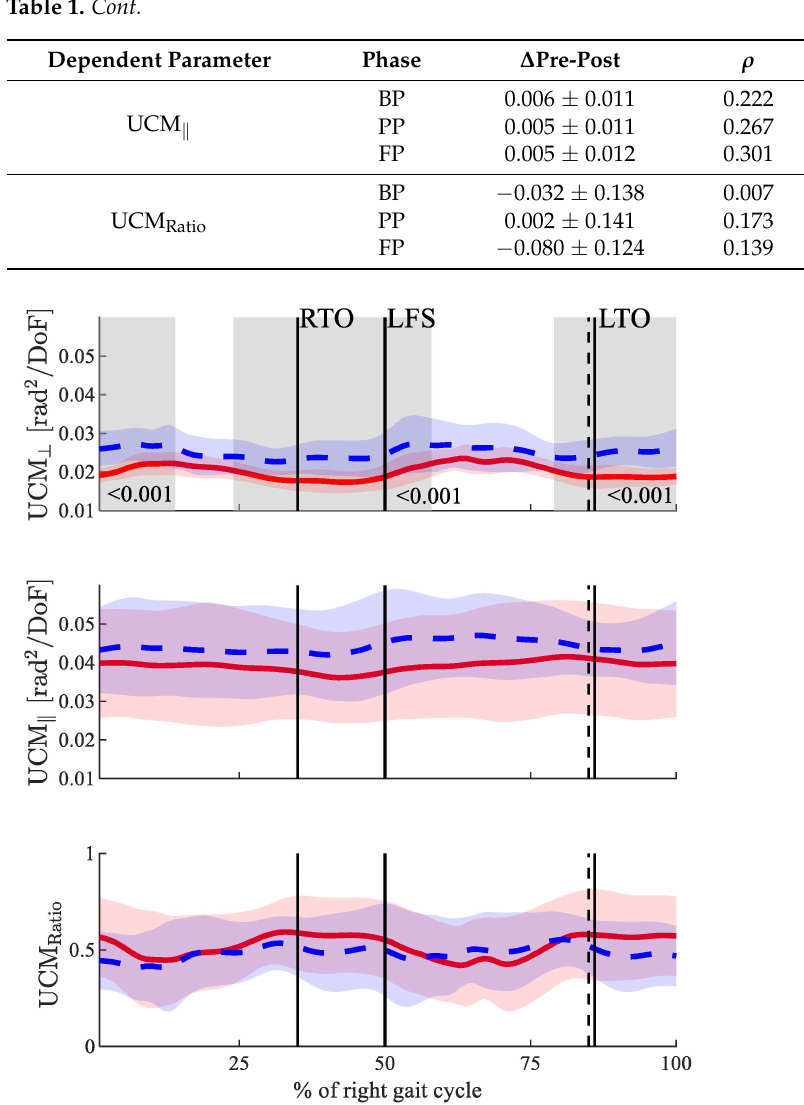
Biology 2022 , 11 , 942 3 of 12